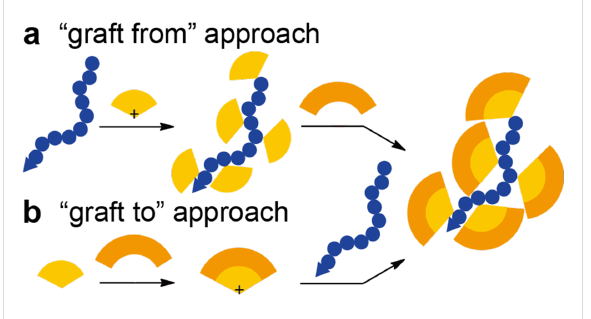
Figure 1: Two synthetic approaches toward the peripherally functional- ized dendronized polystyrenes (blue dotted line = polystyrene, orange sector = dendron of the 1st generation, dark orange sector = dendron of the 2nd generation). (a) Peripheral functionalization of the dendronized polystyrene (“graft from” approach). (b) Dendronization with dendritic diarylcarbenium ions equipped with functional groups (“graft to”